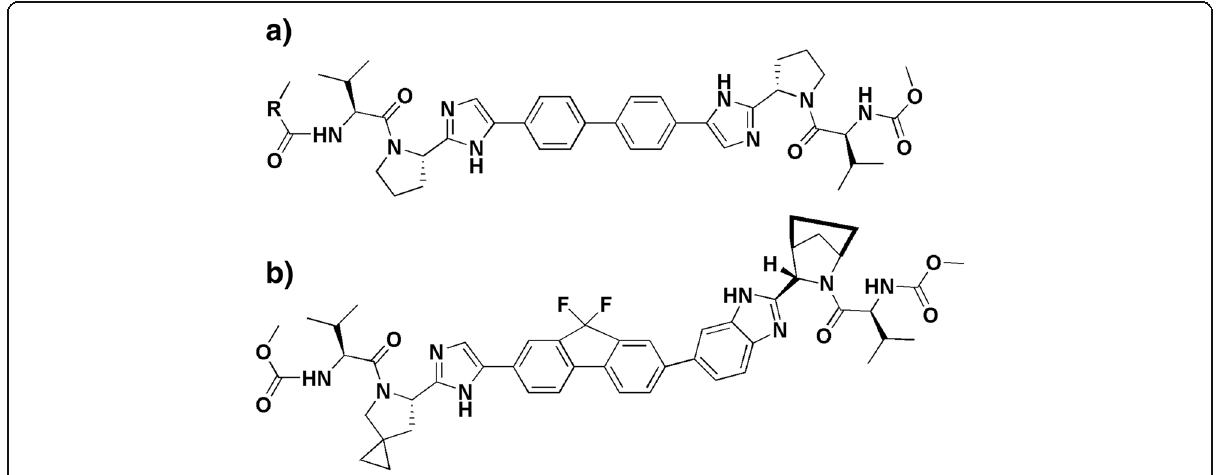
Fig. 1 Chemical structures of a daclatasvir and b ledipasvir